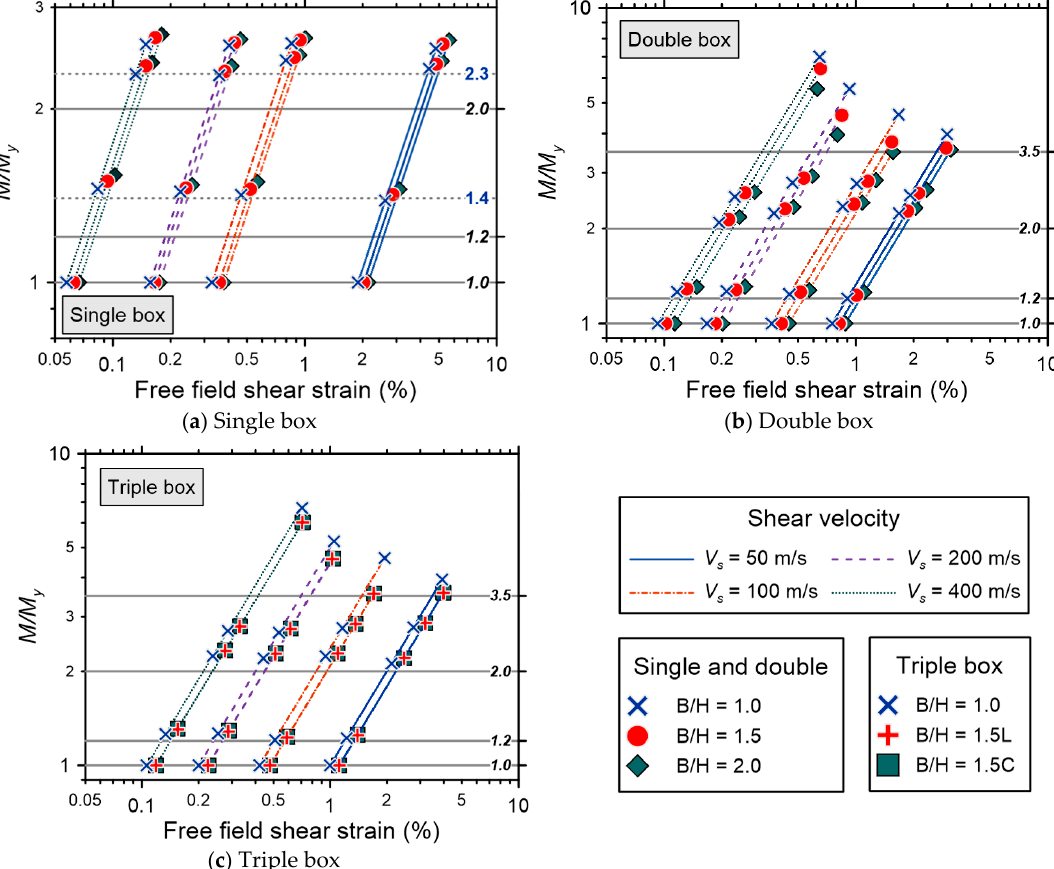
Figure 8. Comparison of damage indices (Dis) for various B / H for single, double and triple box tunnels.